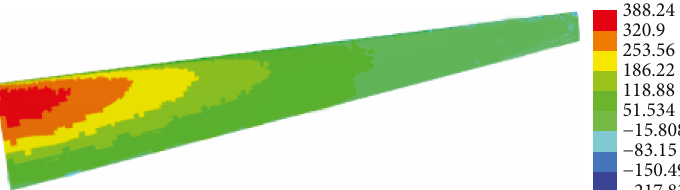
Figure 22: Stress cloud diagram of the lower wing with the layer sequence being [90/45/0/-45/90]